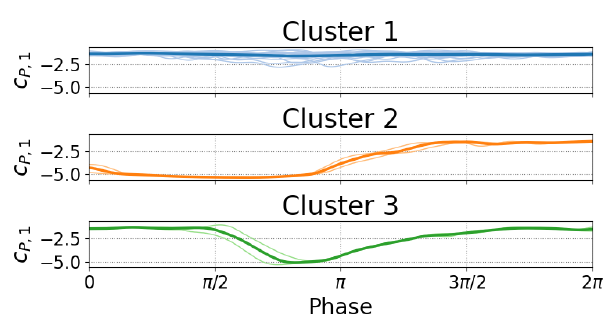
Figure 19. Clustered time series from towing-tank surge experi- ment. Boundary conditions: U ∞ ( φ ) = 2 . 5ms − 1 + 0 . 7ms − 1 sin( φ ), Re = 1 . 25 × 10 6 , f = 0 . 21Hz, α = 10 ◦